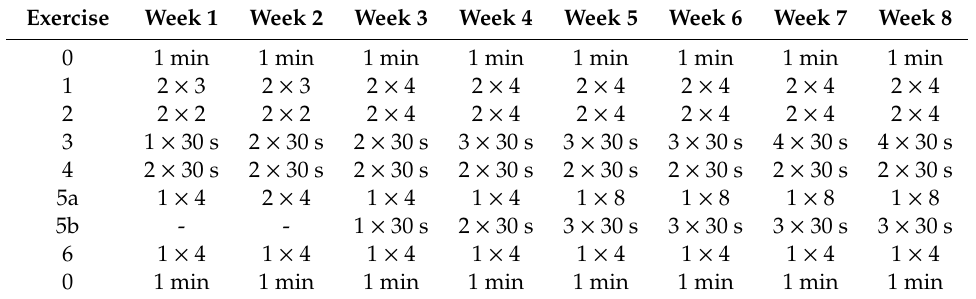
Table 2. Performed exercises during the intervention. Data provided as sets and repetitions or